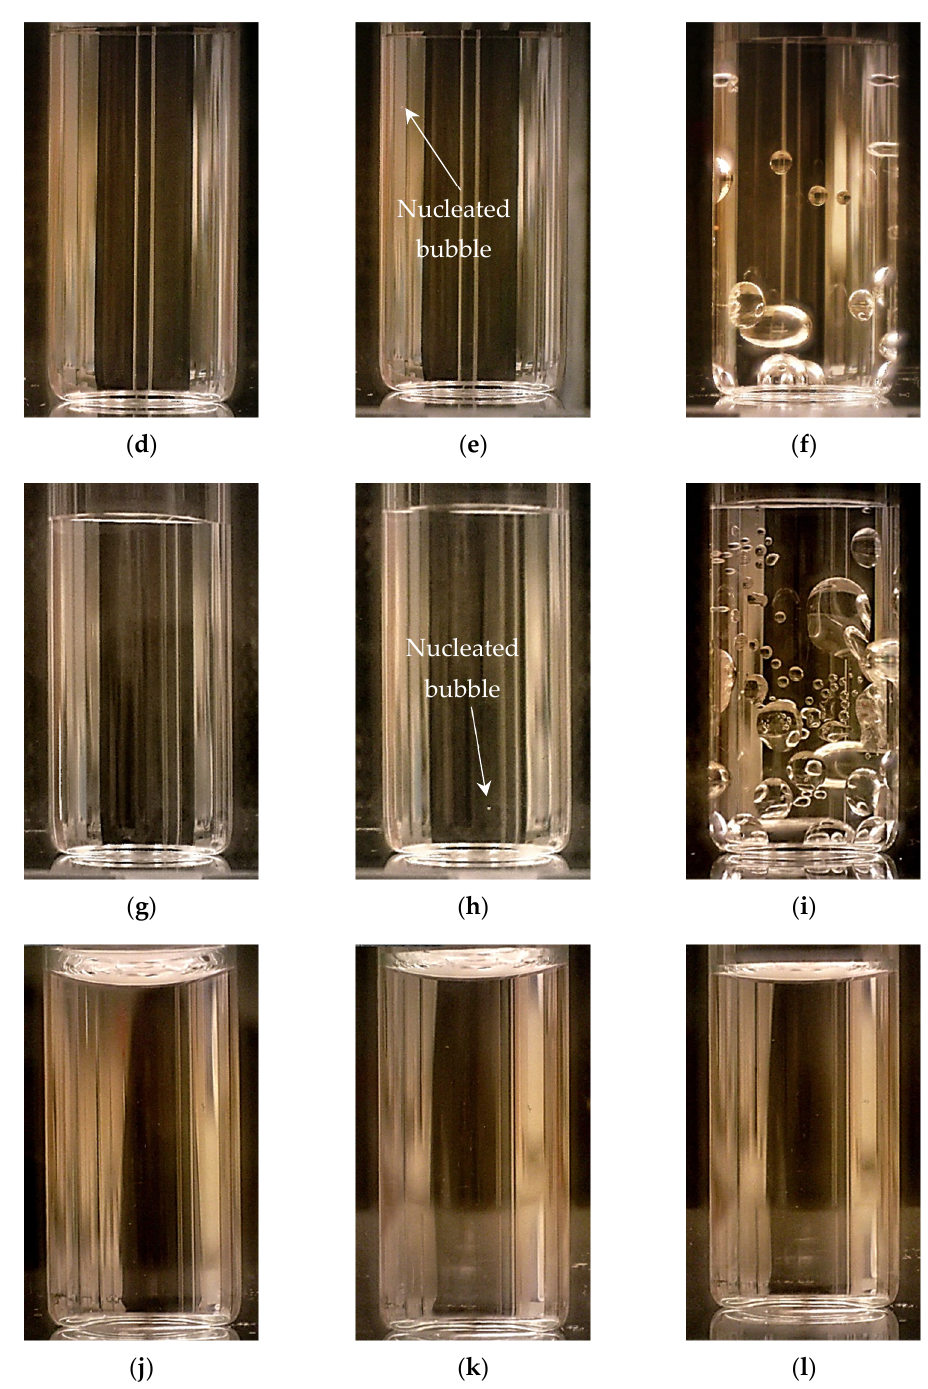
Figure 3. Bubble nucleation phenomena in CM, CF, HT, and untreated vials. ( a ) CM vial at 1013 mbar abs; ( b ) CM vial at 911 mbar abs; ( c ) CM vial at 167 mbar abs; ( d ) CF vial at 1013 mbar abs; ( e ) CF vial at 911 mbar abs; ( f ) CF vial at 167 mbar abs; ( g ) HT vial at 1013 mbar abs; ( h ) HT vial at 911 mbar abs; ( i ) HT vial at 167 mbar abs; ( j ) Untreated vial at 1013 mbar abs; ( k ) Untreated vial at 911 mbar abs; and ( l ) Untreated vial at 65 mbar abs.